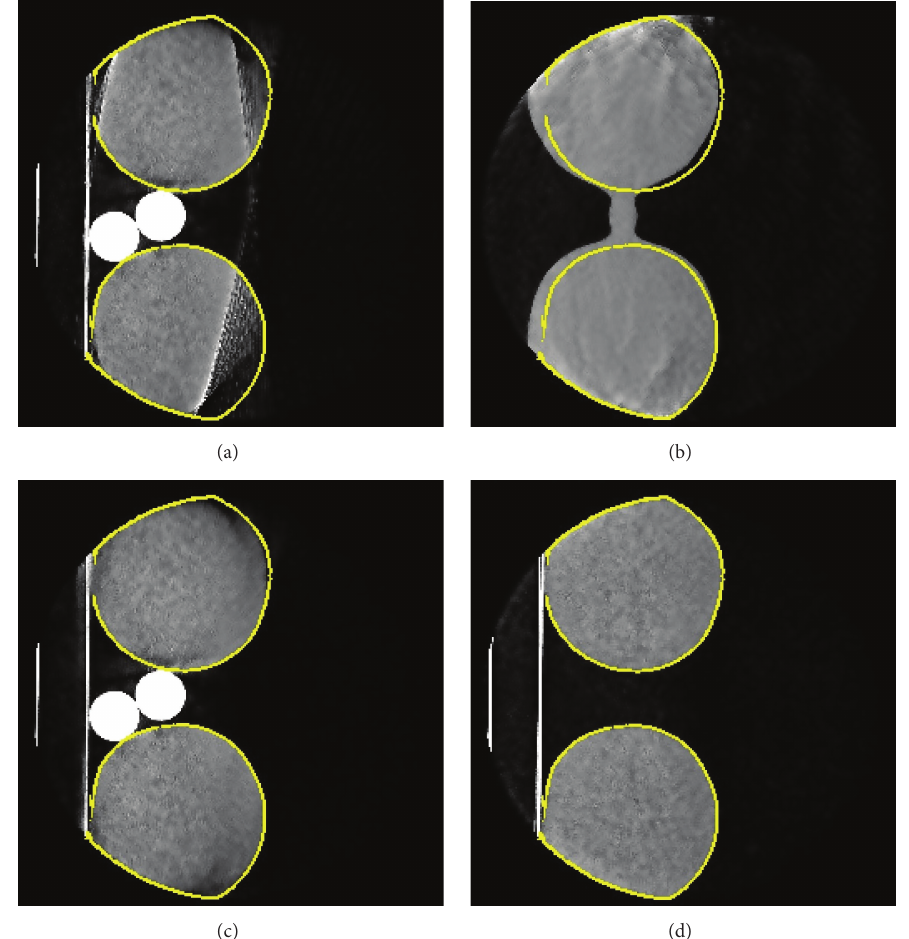
Figure 12: (d) shows the boundary of a slice created from the ground truth data. For comparison, this boundary is also shown in the corresponding slices of the uncorrected (a), corrected (c), and surface data (b). It can be observed that the edges on the right side of the surface data are not perfectly aligned with the ground truth. This results from inaccuracies in the cross-calibration. Window level: [ − 1000,